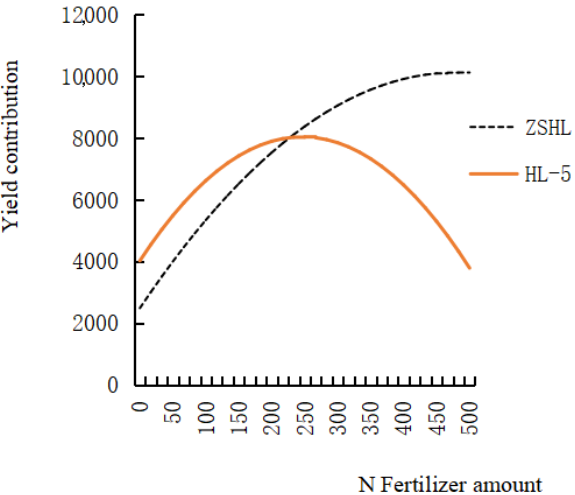
Figure 1. Nitrogen fertilizer contribution to broccoli